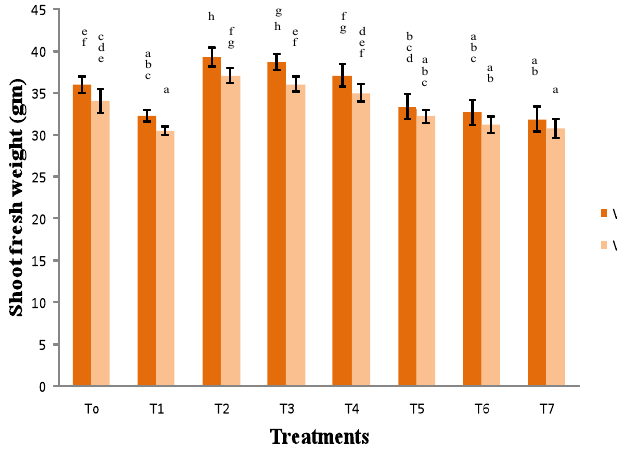
Fig. 1B: Effect of Azospirillum inoculation on shoot fresh weight of two canola varieties (v1 and v2) grown under drought stress. Where, To = Un-inoculated and well watered, T = Un-inoculated and drought exposed, T2 = Seed inoculated and well watered, T3 = Rhizosphere inoculated and well watered, T4 = Seed inoculated with heat killed inoculums and well watered, T5 = Seed inoculated and drought exposed, T6 = Rhizosphere inoculated and drought ex- posed, T7 = Seed inoculated with heat killed inoculums and drought exposed. And V1 = Rainbow, V2 = Con